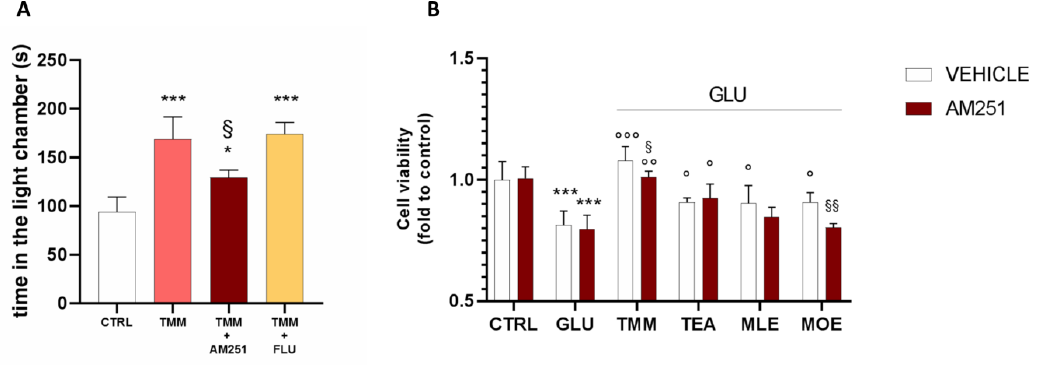
Figure 6. Comparison of the anxiolytic effect of TMM in the presence and absence of AM251 and Vs. CTRL; § p < 0.05 vs. TMM; * p < 0.05 vs. CTRL ( A ). Comparison of the e ff ect on the SH-SY5Y cell viability in the presence and absence of AM251. *** p < 0.001 vs. CTRL; ◦◦◦ p < 0.001 vs. GLU; ◦◦ p < 0.01 vs. GLU; ◦ p < 0.05 vs. GLU; §§ p < 0.01 vs. vehicle; § p < 0.05 vs. vehicle ( B ).